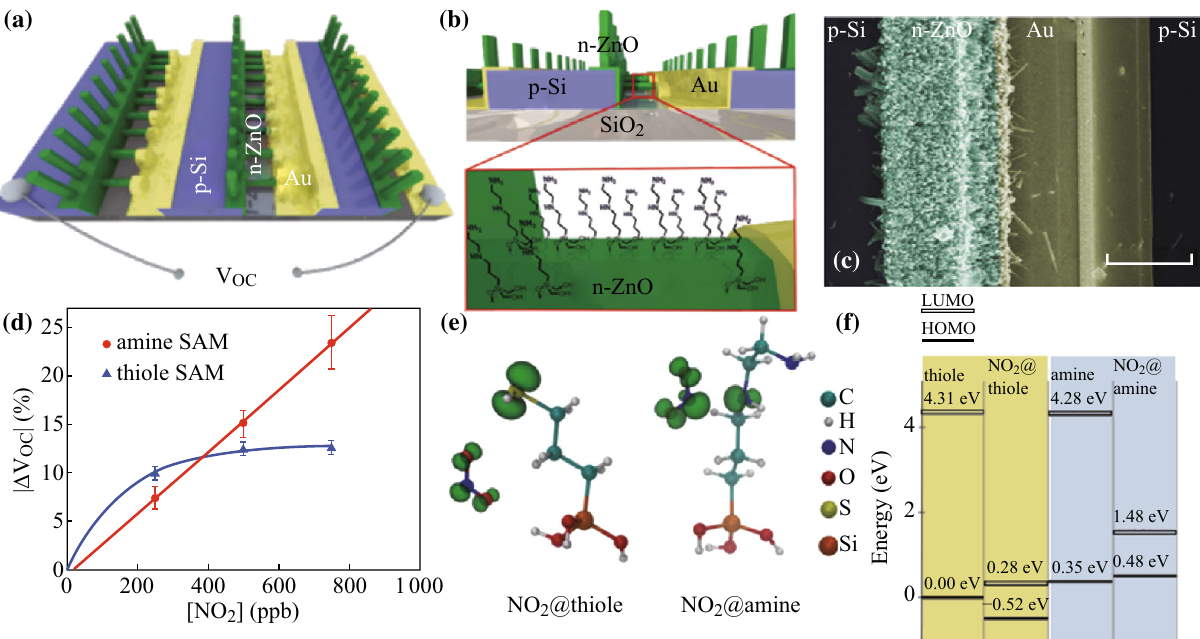
Fig. 5 A highly selective and self-powered gas sensor via organic surface functionalization of p -Si/ n -ZnO diodes. a Schematic of a singular p-n unit composed of p -Si l -trenches. b The surface of the n -ZnO NWs was modified by adding a SAM of functional groups. c SEM image of a singular p -Si/ n -ZnO diode ( scale bar : 10 l m). d Diagram of the D V oc response for different NO 2 concentrations, for amine- and thiol- functionalized devices. e Most stable geometries of NO 2 molecules adsorbed at the thiol and amine functionalities. f Energy levels of the HOMO and LUMO of the functionalities without adsorbed NO 2 and with adsorbed NO 2 . The averaged electrostatic potential from the core region of the Si atom of each functionality was used as reference potential. The HOMO level of the isolated thiol functionality was set to 0 for convenience. Figures adapted from